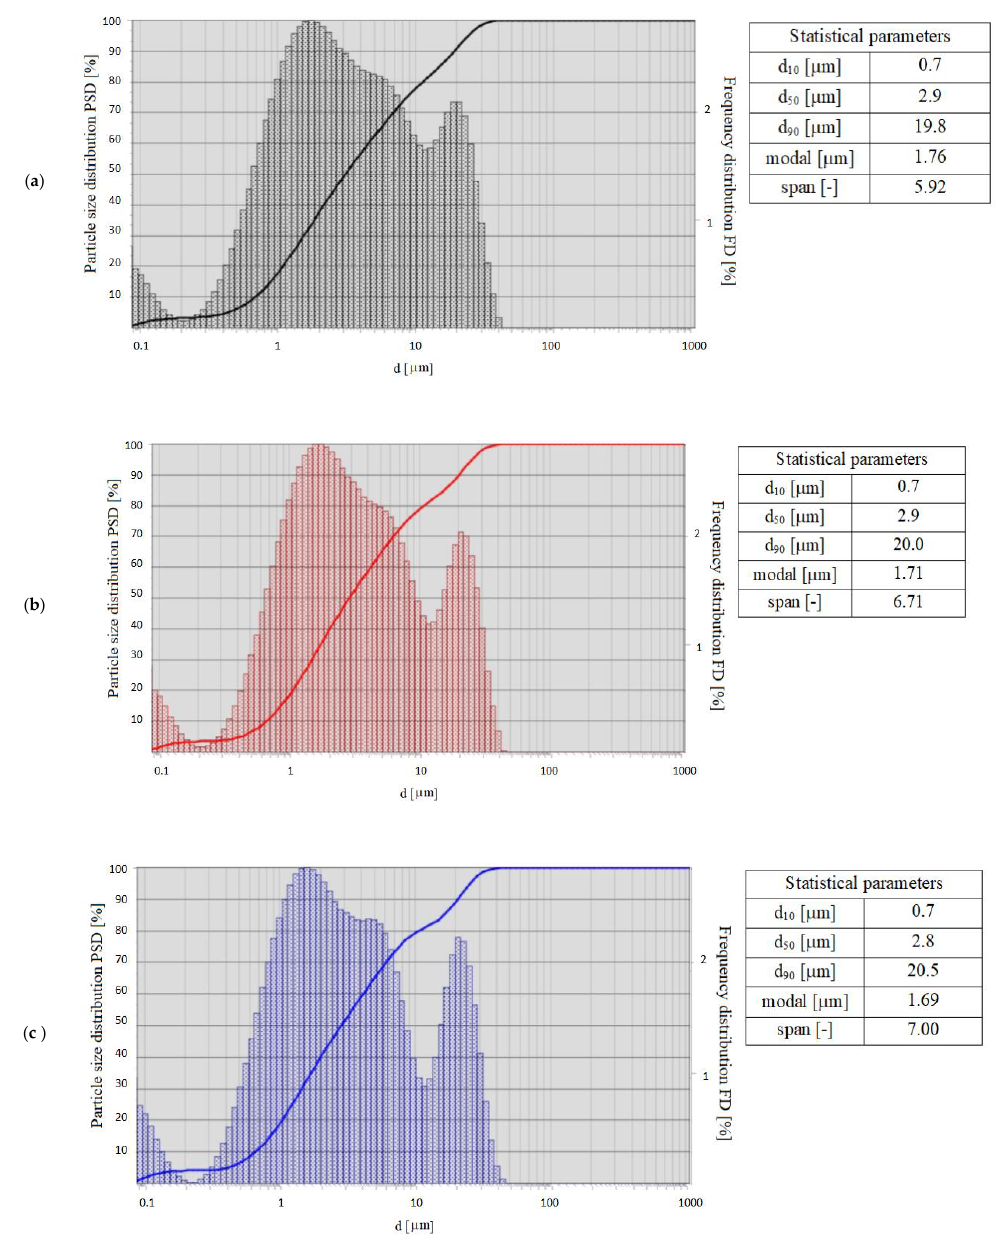
Figure 5. Sizes of characteristic particles determined with the use of the laser diffraction method in the samples of building gypsum: ( a ) 1st measurement, ( b ) 2nd measurement, ( c ) 3rd measurement.